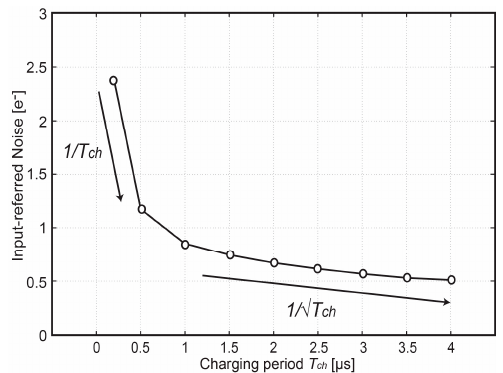
Figure 12. Measured input-referred noise as a function of the charging period T ch [12].